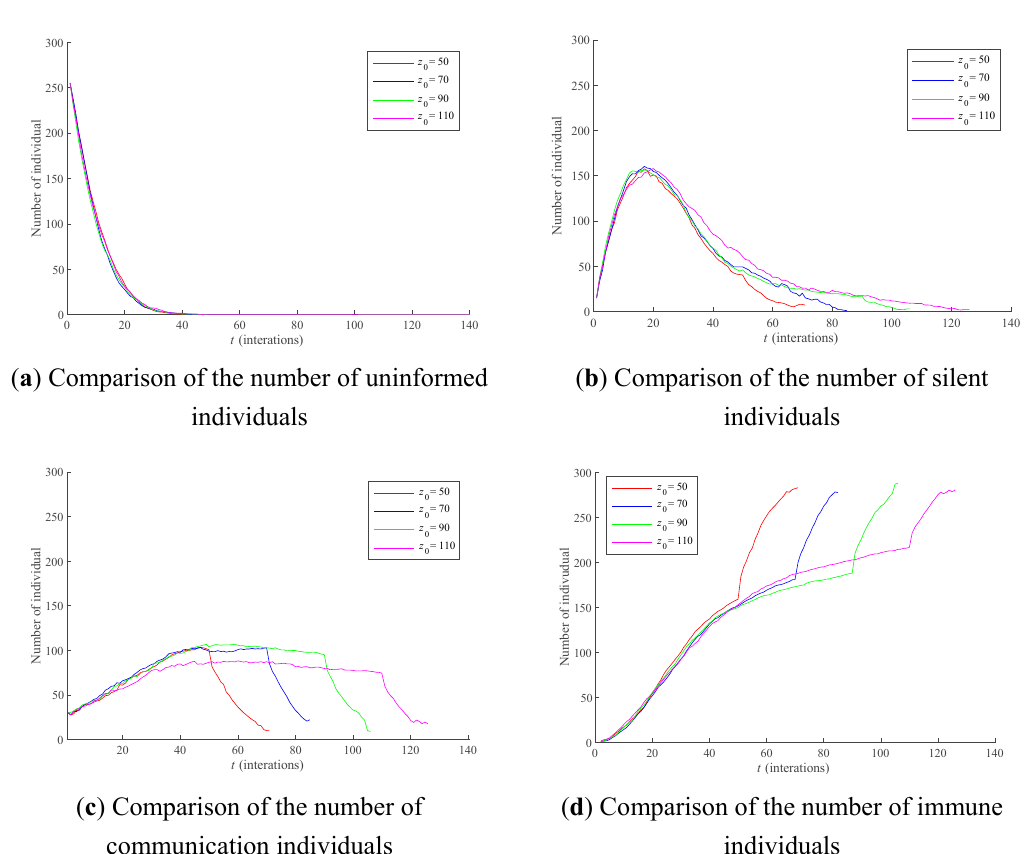
Figure 8. The influence of different z 0 on the polarization process of public opinion. Notes: ( a ) Comparison of the number of uninformed individuals, ( b ) Comparison of the number of silent individuals, ( c ) Comparison of the number of communication individuals, ( d ) Comparison of the number of immune